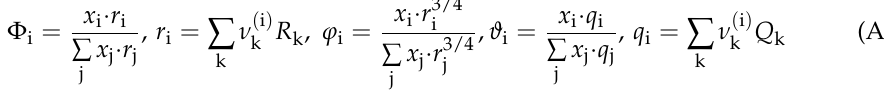
* Constants adapted to Antoine’s expression expressed as its natural logarithm. Values between parenthesis indicate Antoine’s constants expressed in reduced form, Equation